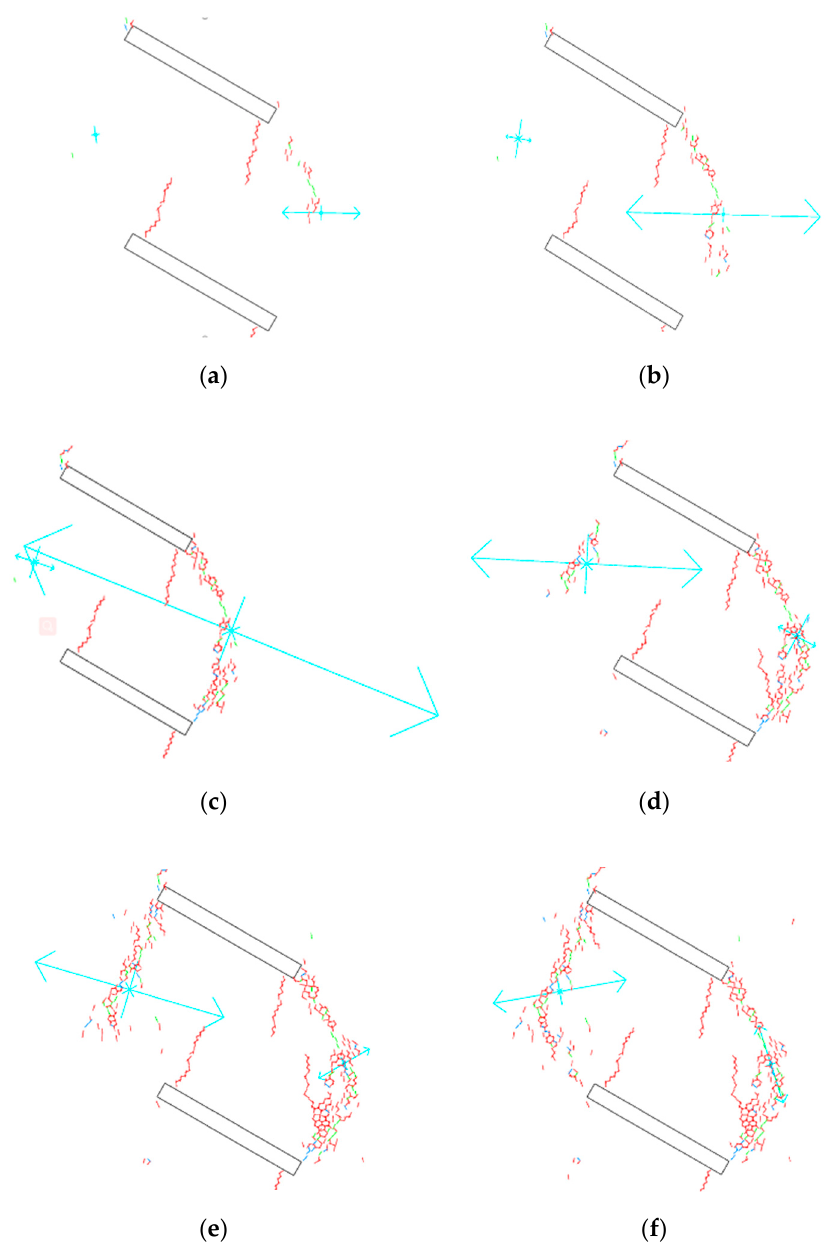
Figure 8. Principal strain rate tensors at di ff erent loading stages. (Pictures a , b , c , d , e , and f respectively show principal strain rate tensors in the two measurement circles corresponding to di ff erent loading stages in Figure 6 when secondary cracks propagate.). Table 4. The values of variable R in the two measurement circles at di ff erent loading stages. Loading stages